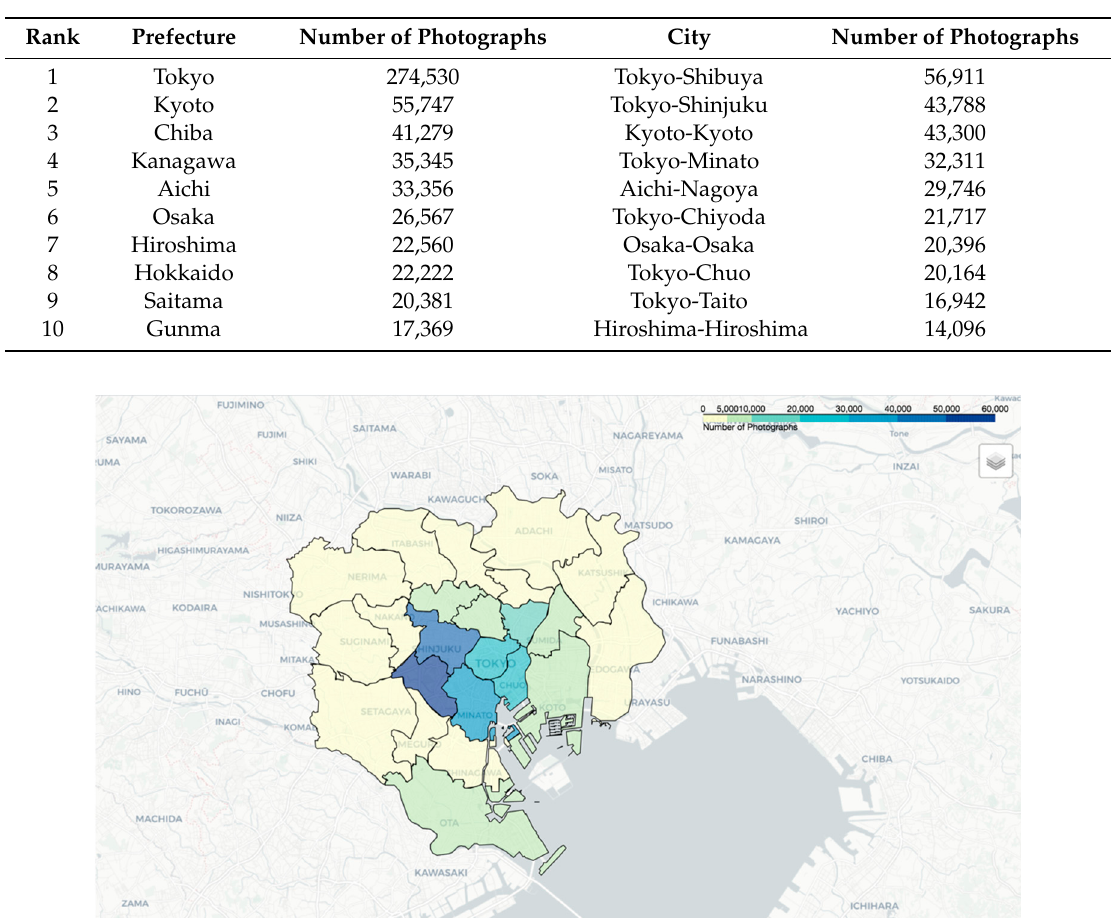
Table 1. Top 10 Japanese prefectures and cities for the number of photographs.